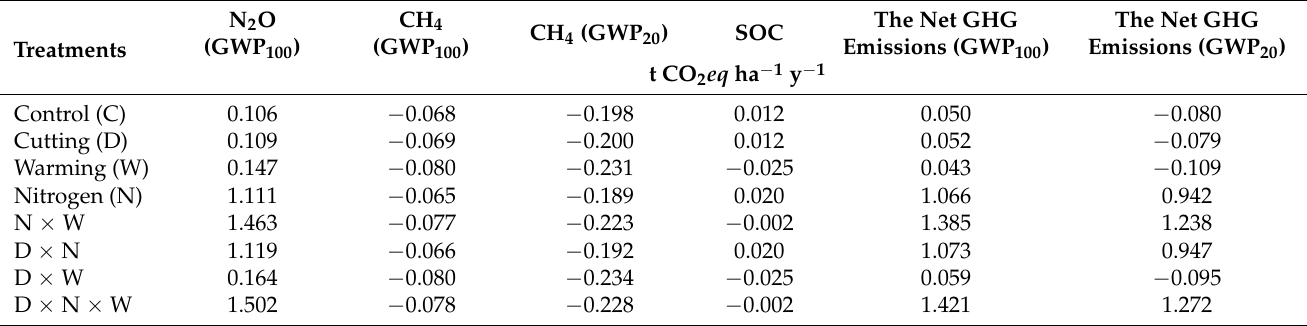
Table 5. Long-term DNDC-estimated (30 years) mean annual GHG (N 2 O, CH 4 ), SOC emissions and net GHG emissions for each field treatment including